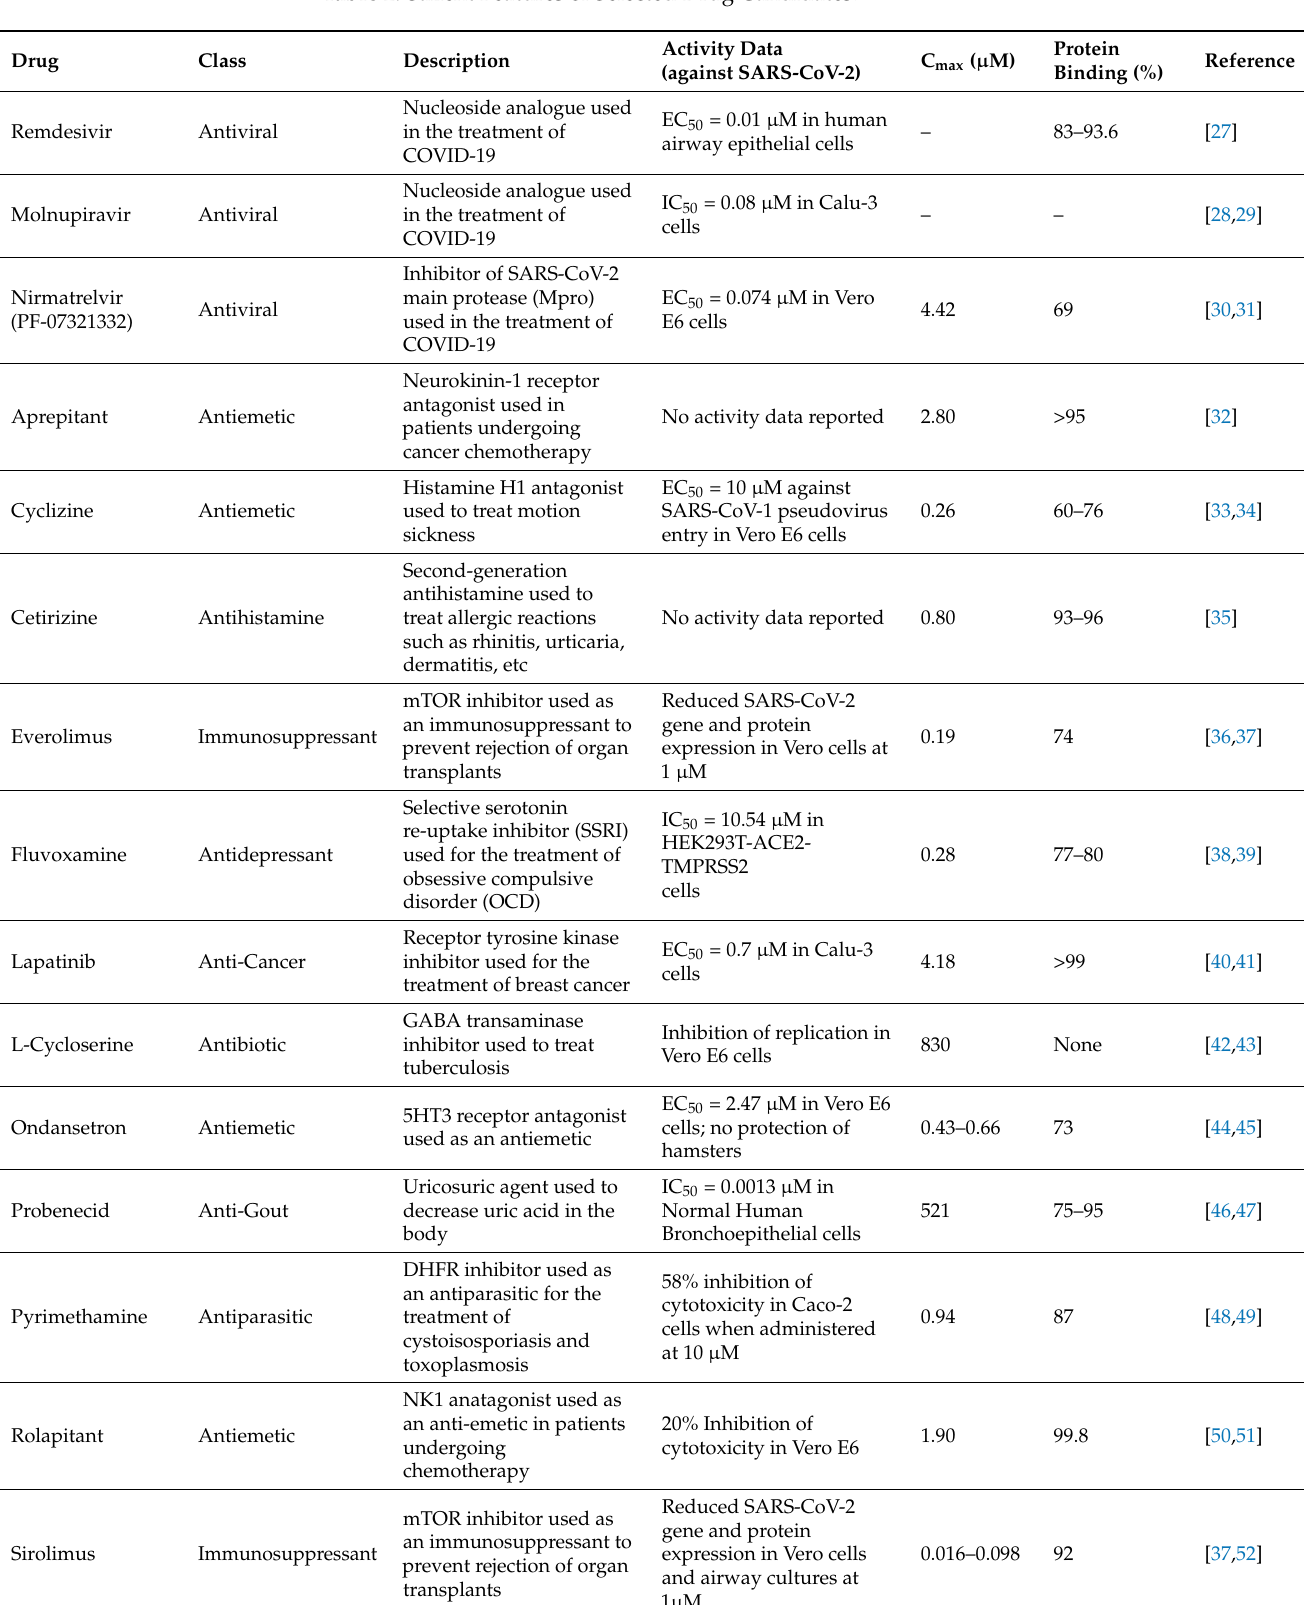
Table 2. Salient Features of Selected Drug